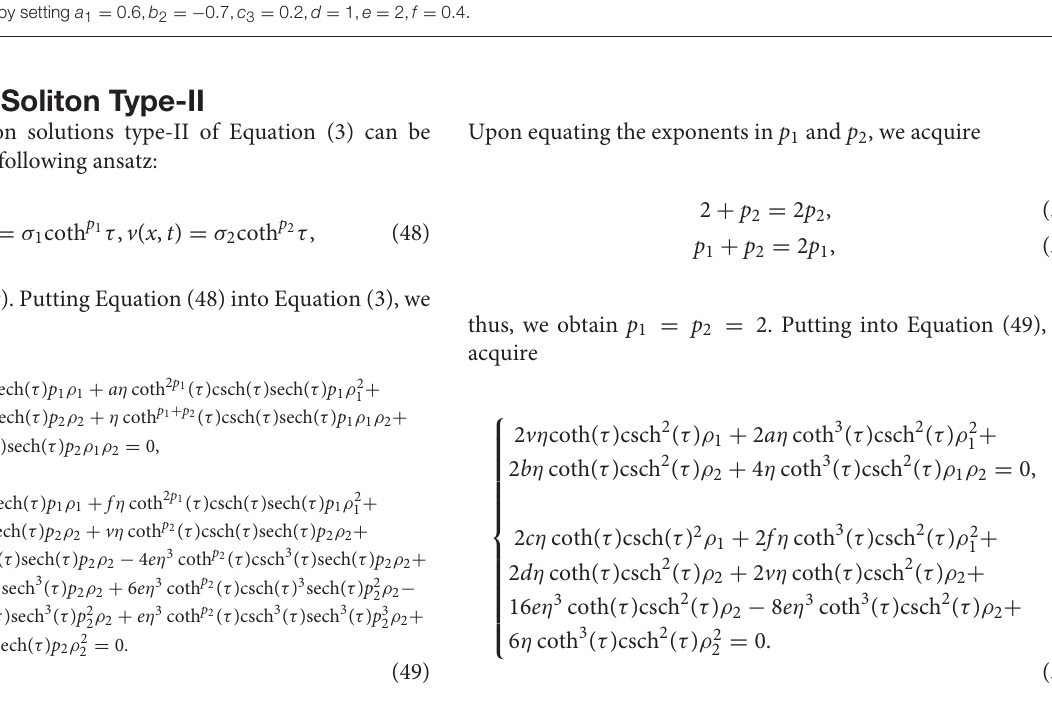
FIGURE 4 | Surface profile of the singular soliton solutions type-I A and B mathematically represented by Equation (47) describing several terminologies in the field of mathematical physics by setting a 1 = 0.6, b 2 = − 0.7, c 3 = 0.2, d = 1, e = 2, f =